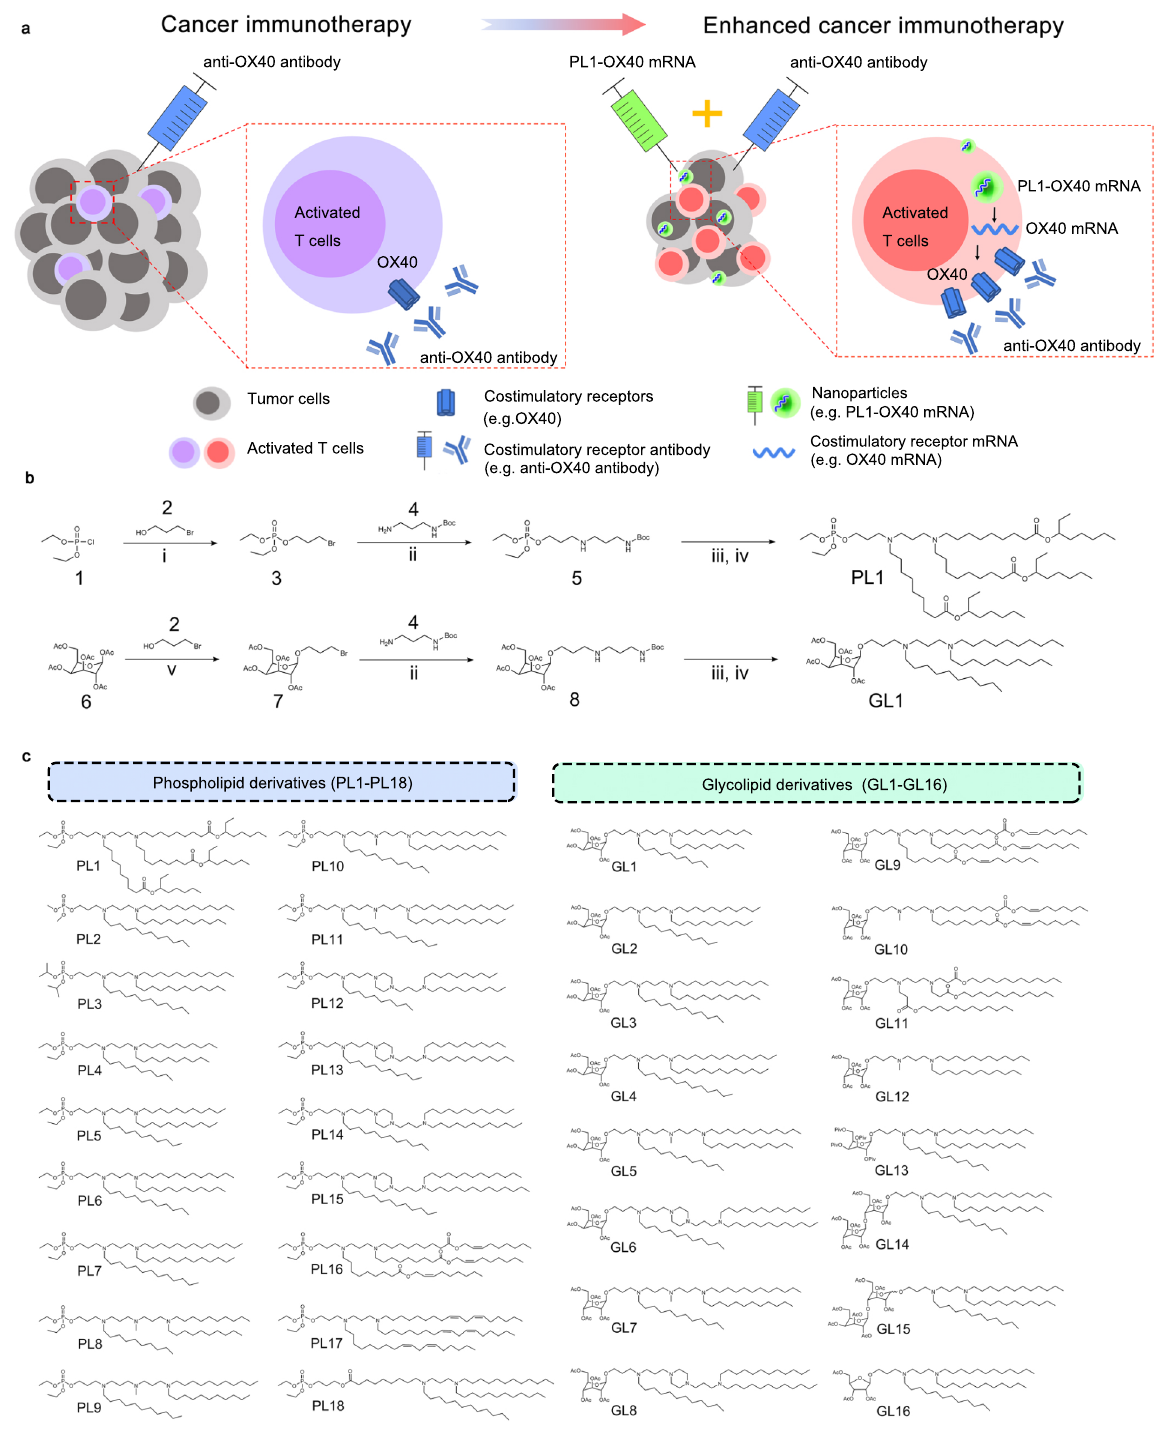
Fig. 1 Stimulation of T-cell-mediated cancer immunotherapy. a Illustration of enhanced cancer immunotherapy via nanoparticles delivering costimulatory receptor mRNA followed by the injection of agonistic antibodies to costimulatory receptors (e.g., PL1-OX40 mRNA + anti-OX40 antibody). b Representative synthetic routes to biomimetic compounds: phospholipid and glycolipid derivatives. i. Et 3 N, Toluene, RT. ii. Et 3 N, DMF, RT. iii. TFA, CH 2 Cl 2 , RT. iv. aldehyde, Et 3 N, THF, NaBH(OAc) 3 . c Structures of phospholipid derivatives PL1-PL18 and glycolipid derivatives